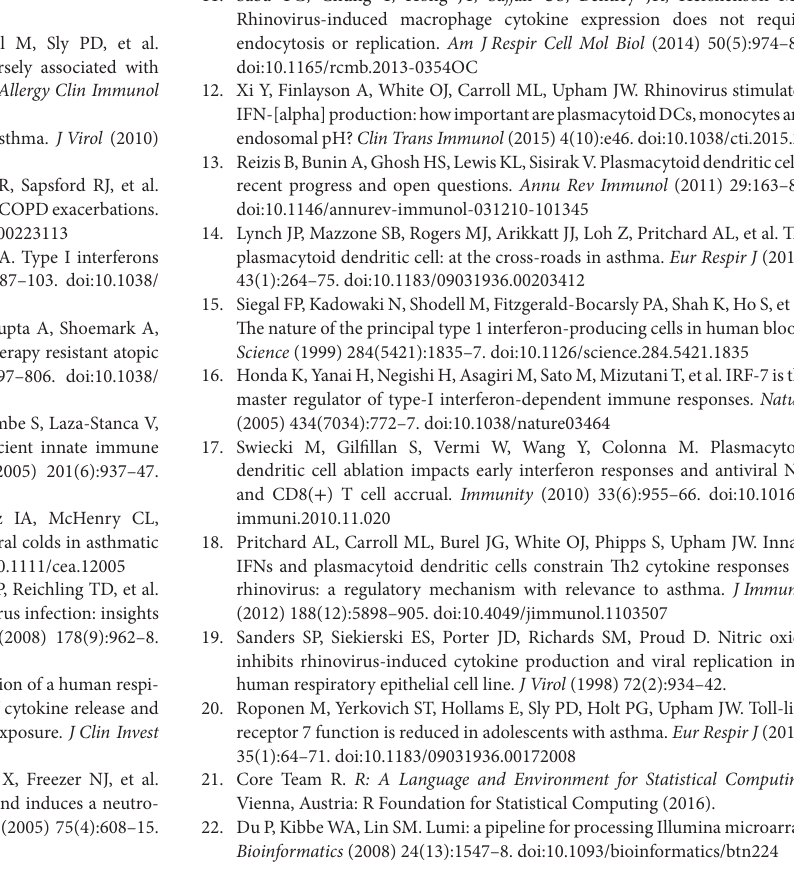
FigUre s1 | The cytokine and expression level of genes of interested in pure pDC following RV16 stimulation. FACS purified pDC and PBMC ( n = 2) were stimulated with RV16 for 24 h. IFN- α and IL-6 protein (a,B) in the cultured supernatant were measured using